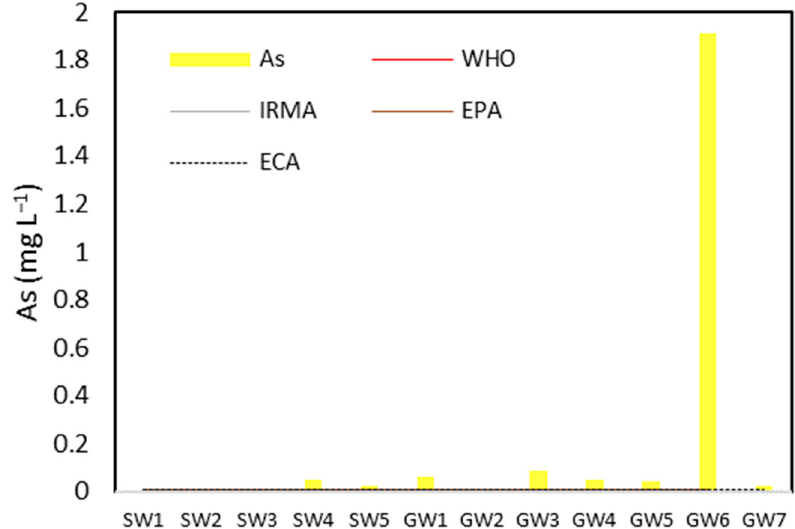
Figure 4. Arsenic concentrations were found in surface water (SW) and groundwater (GW) in the samples examined.